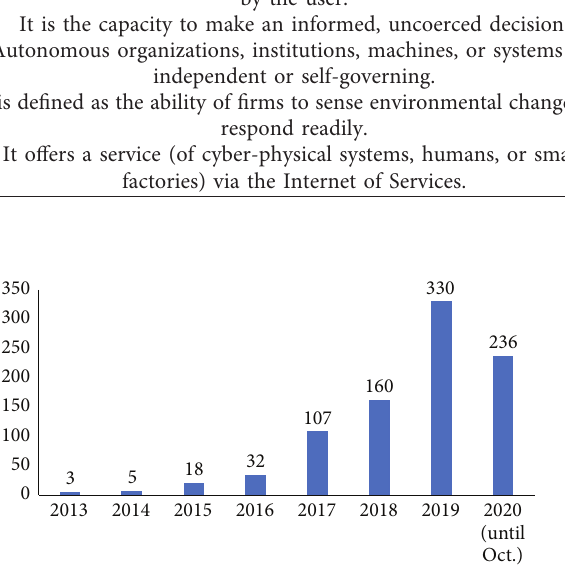
Figure 5: Number of publications per